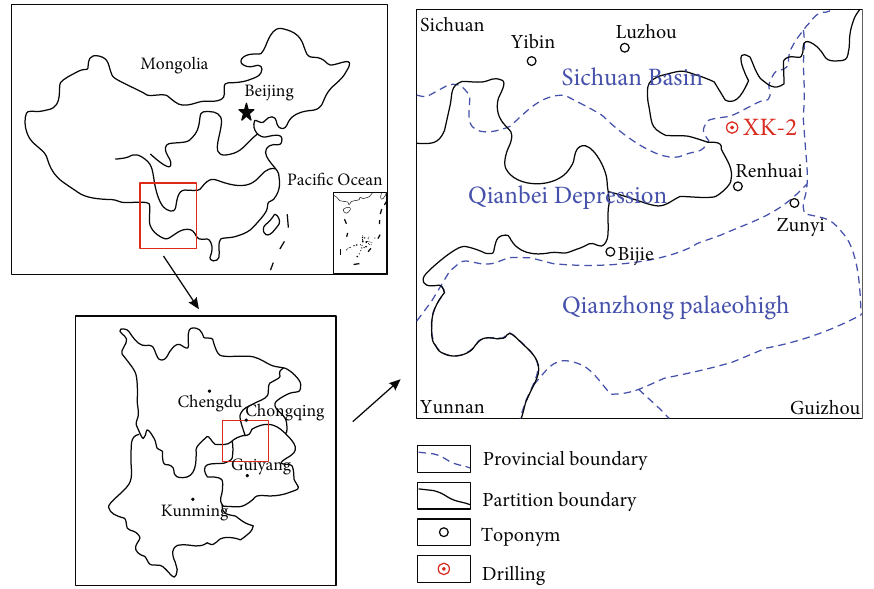
Figure 1: Location of the study area.